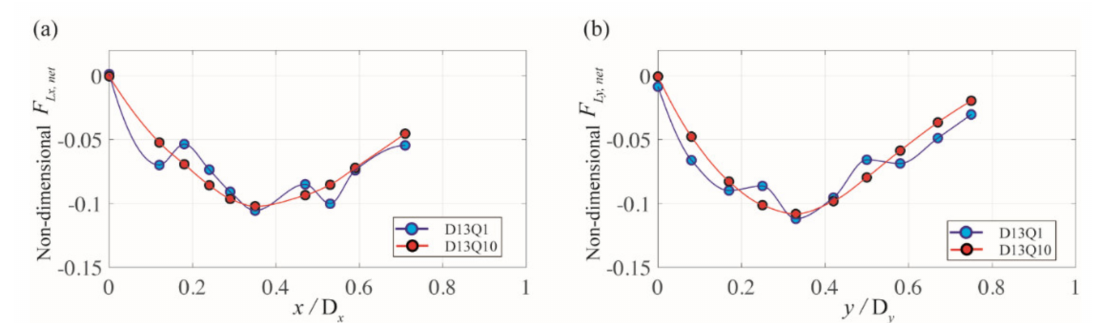
Figure 7. Variation in the ( a ) x -directional and ( b ) y -directional net force exerted on a 13- µ m particle along the line of symmetry of the rhombic microchannel. The blue and red symbols represent the flow rates of 1 and 10 µ L / min, respectively.